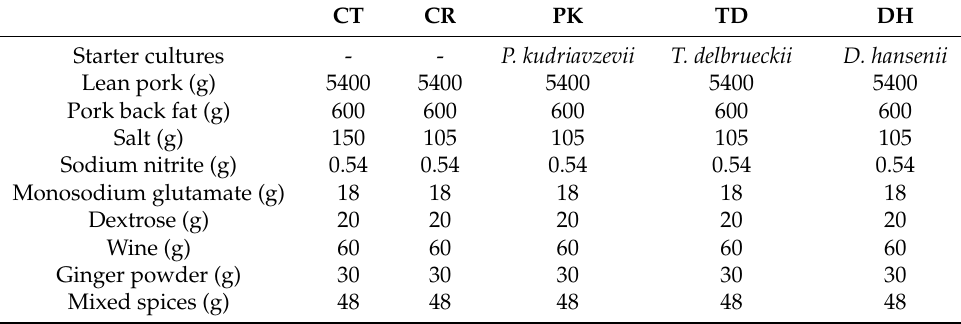
Table 1. The recipes and starter cultures for different sausages.